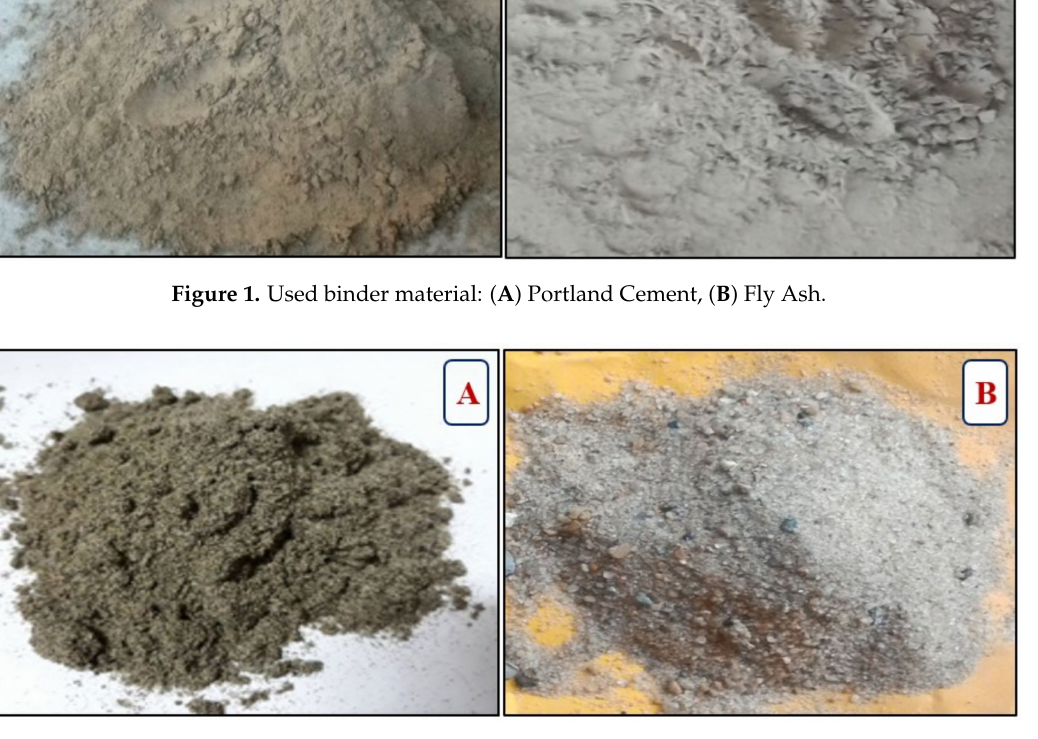
Figure 2. Used fine aggregate: ( A ) Black Sand and ( B ) Normal Sand